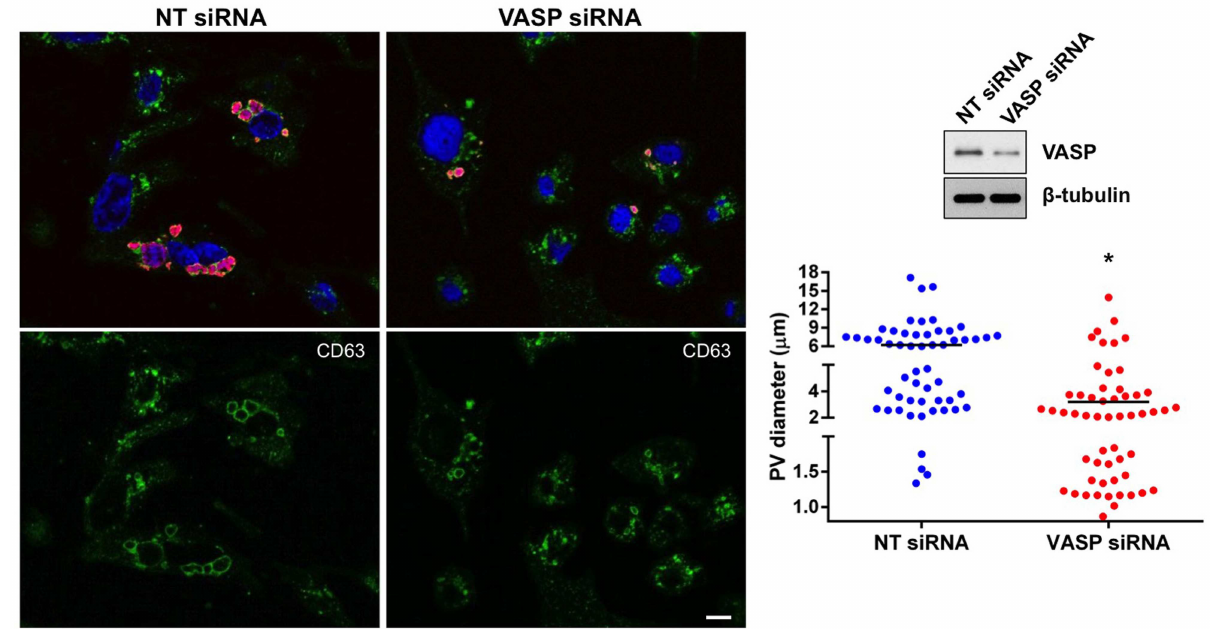
Fig 5. VASP activity is required for optimal PV formation. THP-1 cells were transfected with non-targeting (NT) or VASP-specific siRNA and knockdownconfirmed by immunoblot. Cells were processed for confocal microscopy at 72 hpi. DNA was labeledwith DAPI (blue), and CD63 (green) and C . burnetii (red) were detected with antibodies.Bar, 10 μ m. The scatter plot displays PV diameter in NT or VASP siRNA-transfected cells. PV measurements were taken from at least 15 randomly selected fields. When multiple vacuoles were visible, the two largest vacuoles were measured in a single cell. The horizontal bar indicates average vacuole size. * indicates p < 0.0001 accordingto a Student’s t test comparingvacuole size in NT and VASP siRNA-transfected cells. VASP knockdown results in formation of smaller